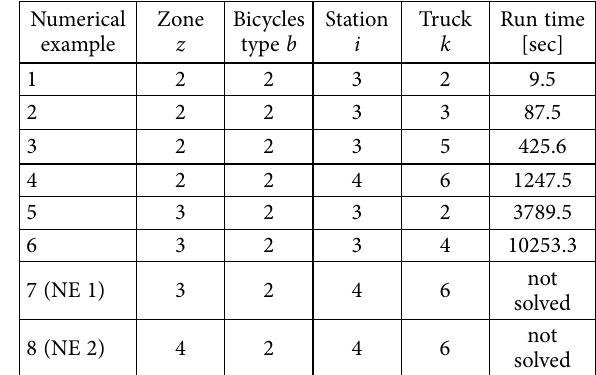
Table 11. Demand prediction of bicycle types in stations